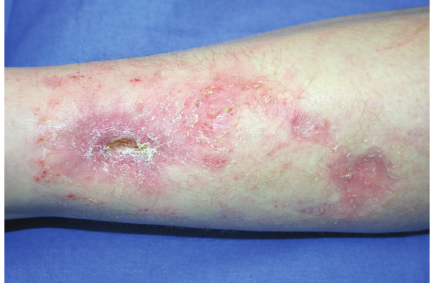
Figure 3: Result 3 months after first grafting session.